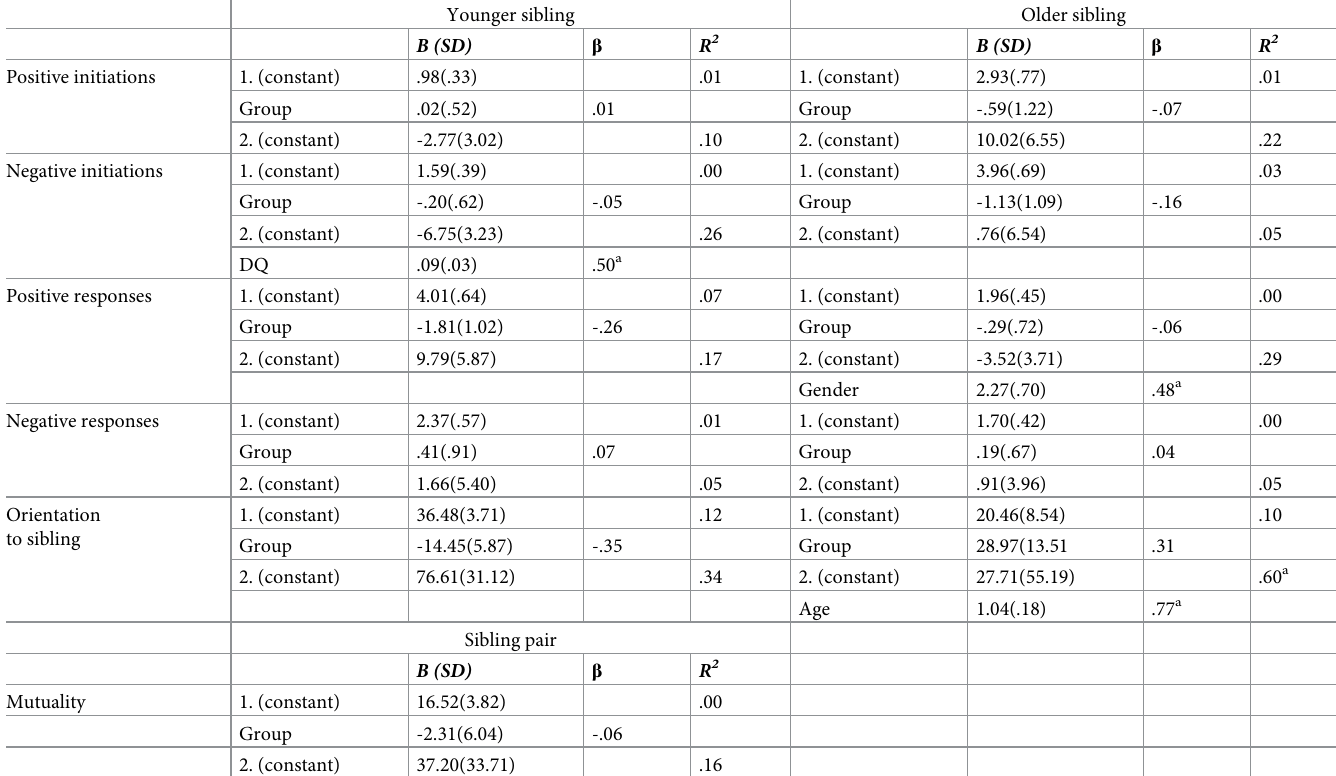
Table 4. Regression coefficients for significant